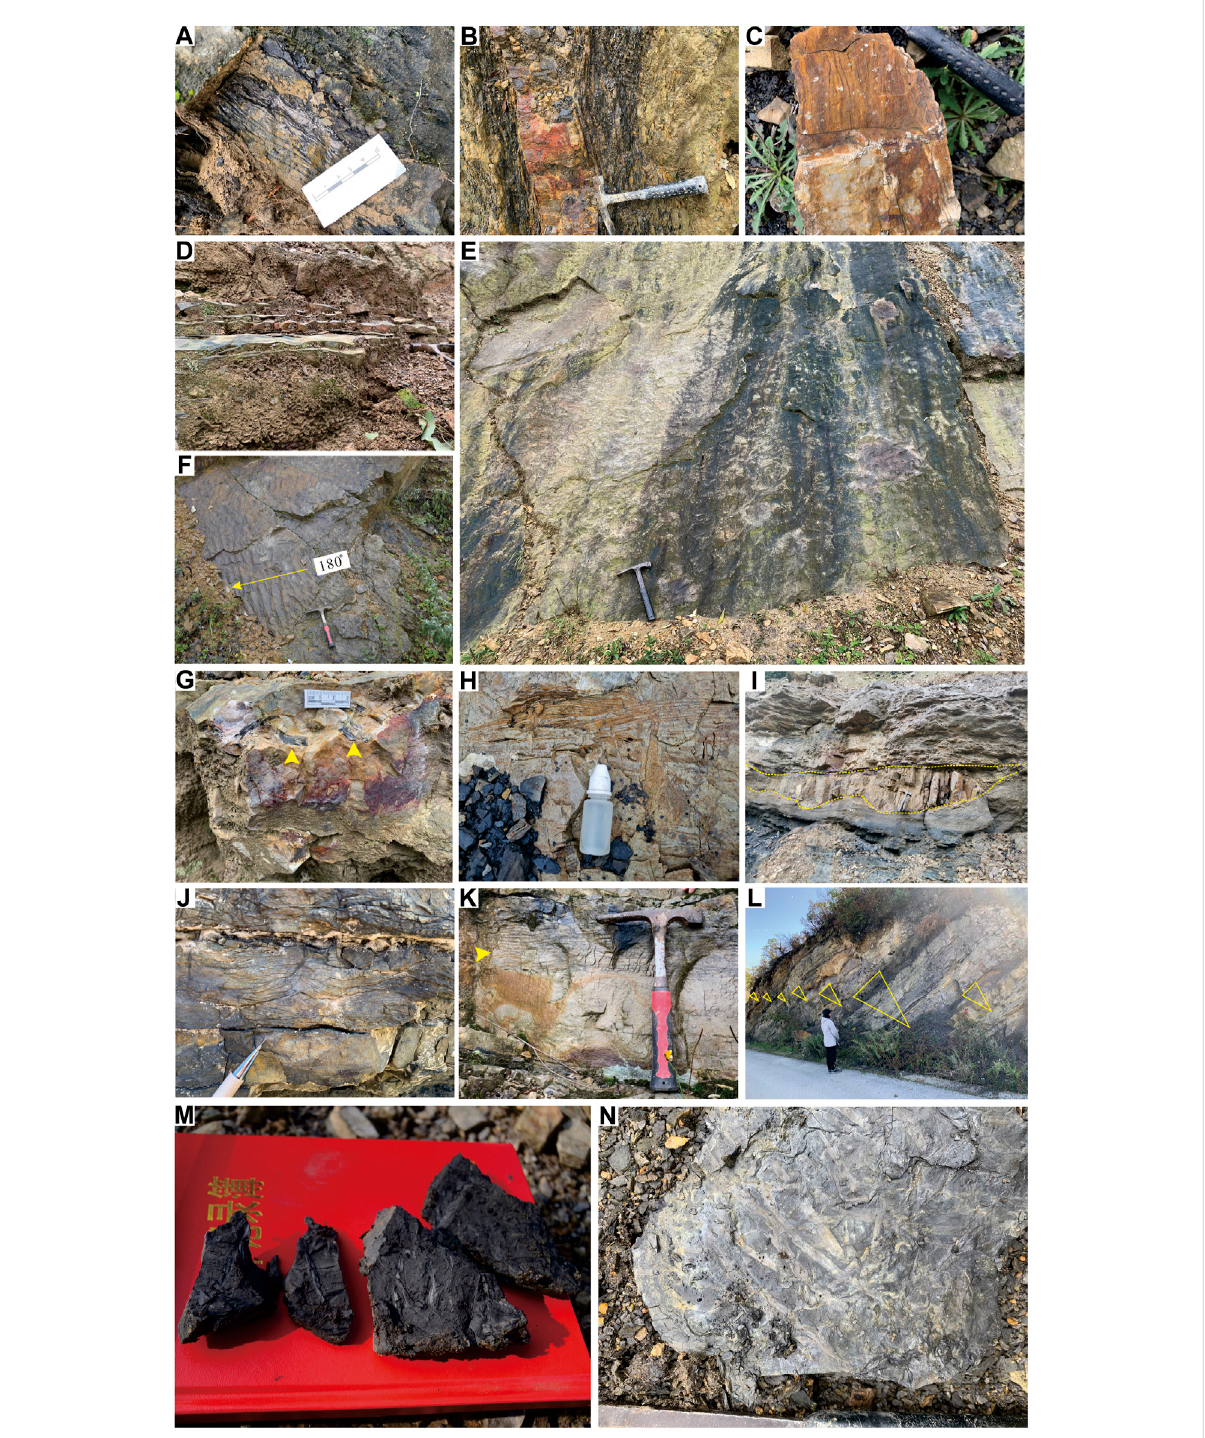
FIGURE 7 Faciesassociation2,intertidalorsubtidalzone. (A) Heterolithicwith fl aserbedding,sectionSMK. (B) Heterolithicwithlenticularbedding,section DHZ. (C) Lithofacies Sc (cross-bedded sandstones) with awash cross-bedding, section LDZ. (D) Lithofacies Ssr (Symmetrical rippled sandstones), section SMK. (E) Lithofacies Sir (interference rippled sandstones), section SMK. (F) Lithofacies Sar (asymmetrical rippled sandstones) with the current directionof180 ° ,sectionHTH. (G) Quartzsandstonewithmuddybands,sectionSMK. (H) LithofaciesScwithawashcross-bedding,sectionLDZ. (I) Small dunes with erosional base, disappearing laterally (yellow dashed line), gully setting, section LDZ. (J) Lithofacies Sc with wavy cross-bedding, section DHZ. (K) Lithofacies Sc with parallel bedding and herringbone bedding (yellow arrow), section DHZ. (L) Repeated seven fi nning upwards cycles with erosional bases of each sequence, tidal channel setting, section HTH. (continued). Facies association 2, supratidal zone. Lithofacies Mp with abundant unidenti fi ed leaf fossil, section LDZ (M) and section SMK (N) .